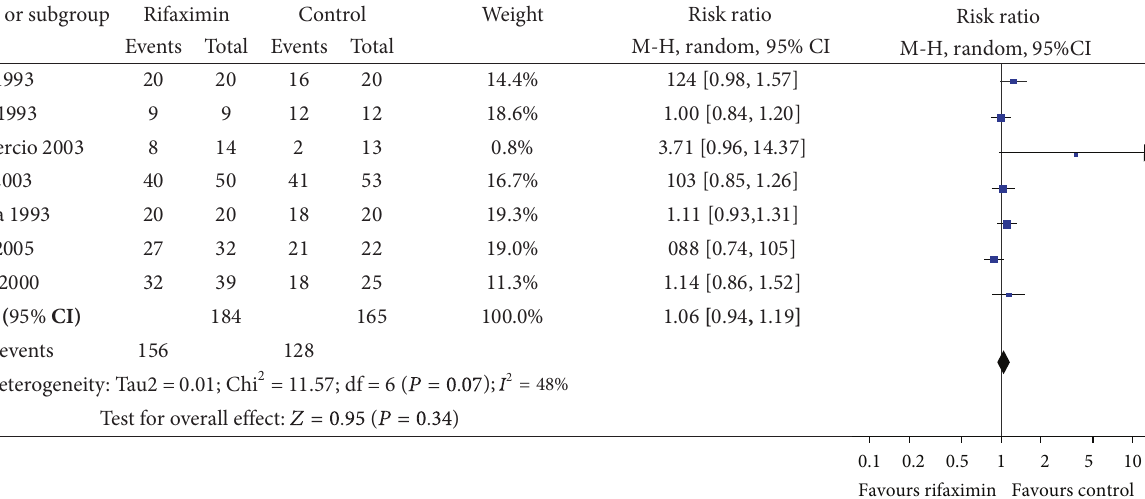
Figure 2: Efficacy of rifaximin versus nonabsorbable disaccharides in the treatment of hepatic encephalopathy. M-H: Mantel Haenszel.